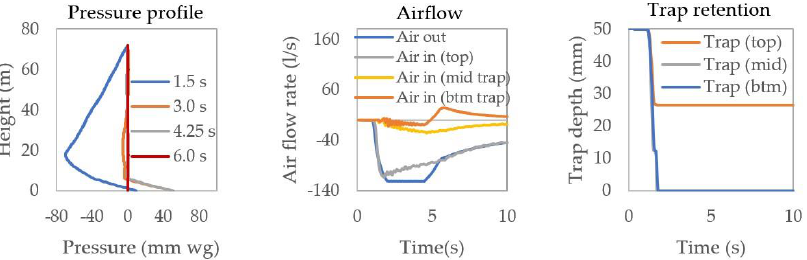
Figure 11. Simulated elements of operational performance, including the stack pressure profile, airflow, and resultant trap retention depth for the 20 story building as a single-stack system with a 150 mm diameter stack.